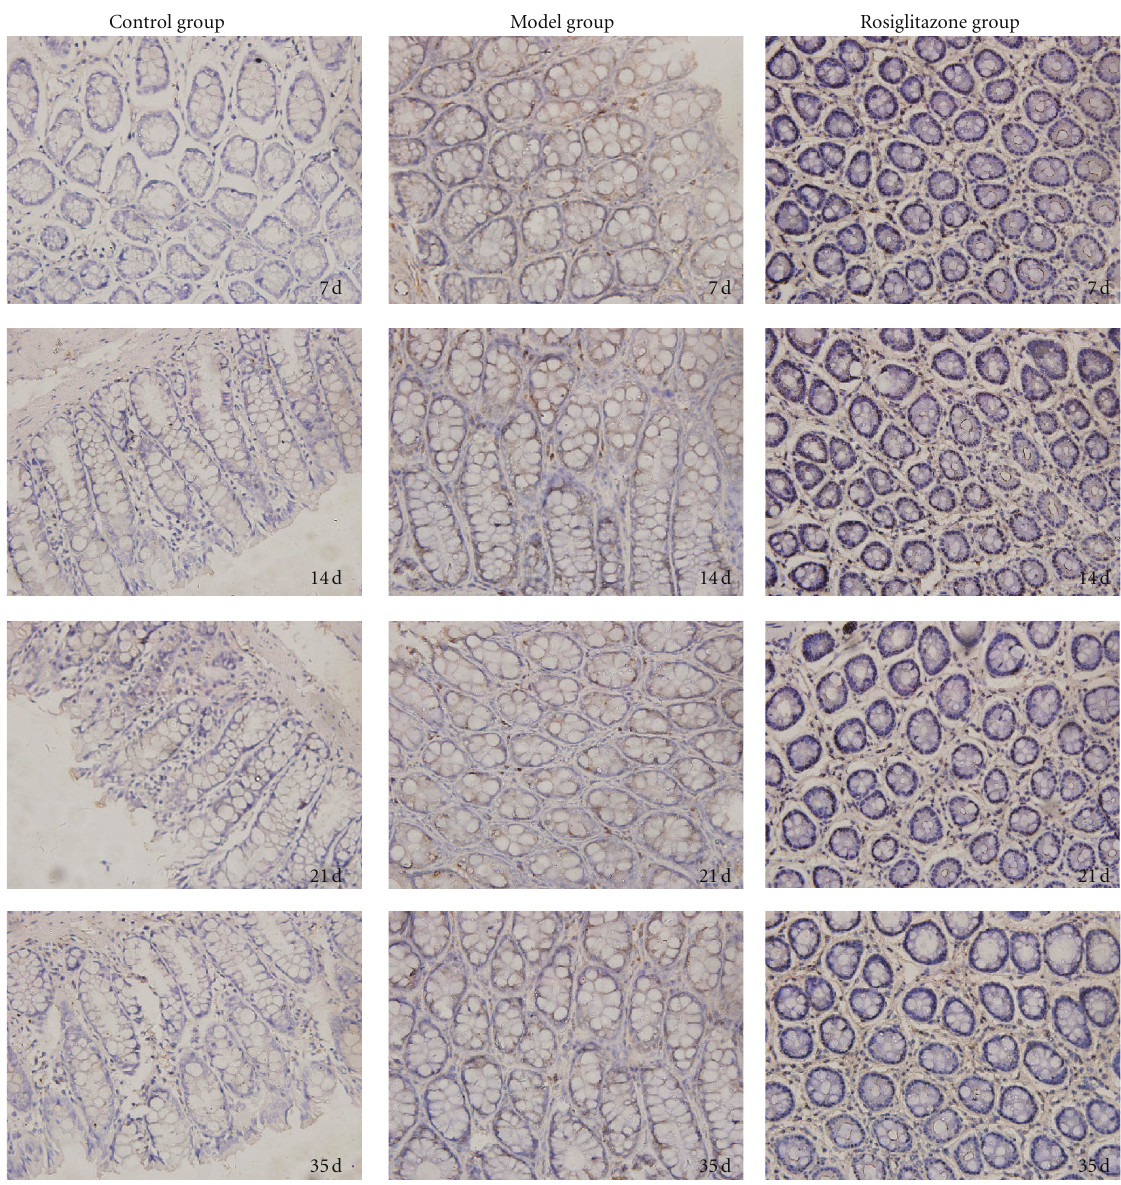
Figure 4: Colonic mucosal TNF- α protein expression in the control group, UC model group, and rosiglitazone treated group on days 7, 14, 21, 35. In the control group, expression of TNF- α protein in the colonic mucosa was significantly less compared to the UC model group ( P < 0.05). In the rosiglitazone treatment group, TNF- α protein expression reduced significantly than that of the model group on days 7, 14, 21 and 35 ( P <